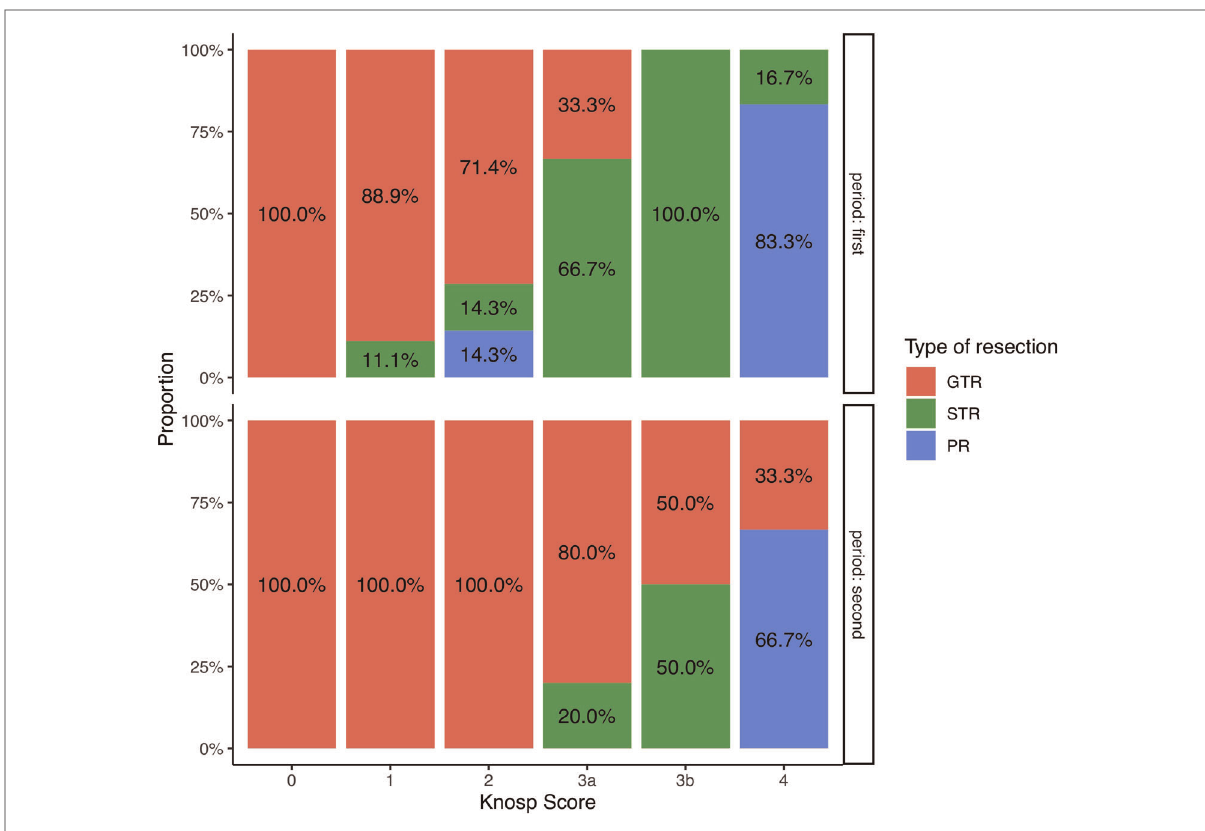
FIGURE 3 Bar-plot representation of the resection rates depending on the Knosp score during the fi rst and the second period of